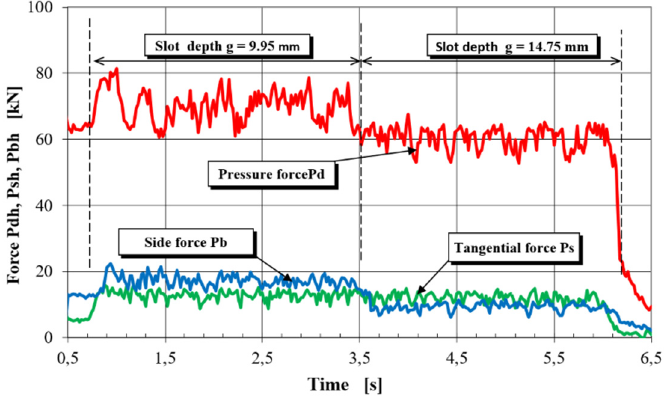
Figure 18. View of the exemplary course of Pd, Pb and Ps force values during mining with disk tool with high pressure water jet assistance—concrete sample compressive strength R c = 19.5 MPa, disk edge angle 2 β = 110°, mining radius 250 mm, disk edge penetration depth h = 10.15 mm, slots spacing 2B = 75 mm [1].